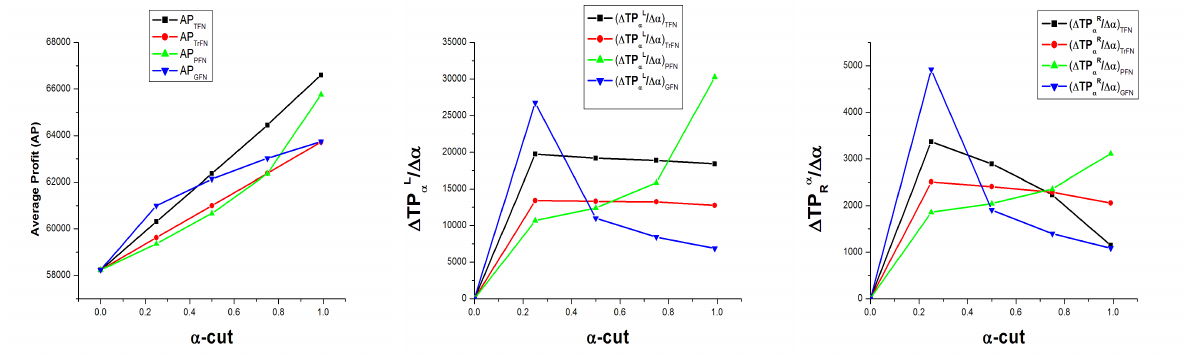
Figure 2. Graphical representation of average profit with α